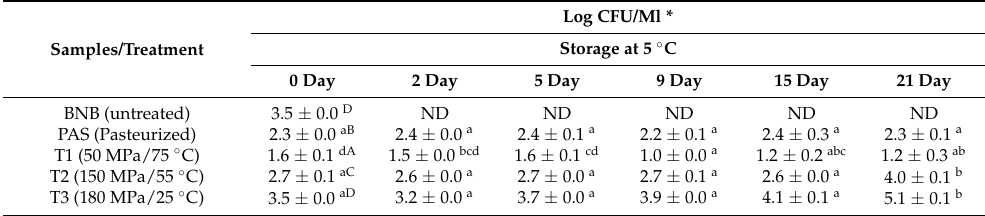
Table 2. Total count of mesophilic aerobes of the Brazil nut beverage (BNB) treated with high-pressure homogenization (HPH) and pasteurization (PAS) and stored at 5 ◦ C for 21 days. Log CFU/Ml * Storage at 5 ◦ C Samples/Treatment 0 Day 2 Day 5 Day 9 Day 15 Day 21 Day BNB (untreated) 3.5 ± 0.0 D ND ND ND ND ND PAS (Pasteurized) 2.3 ± 0.0 aB 2.4 ± 0.0